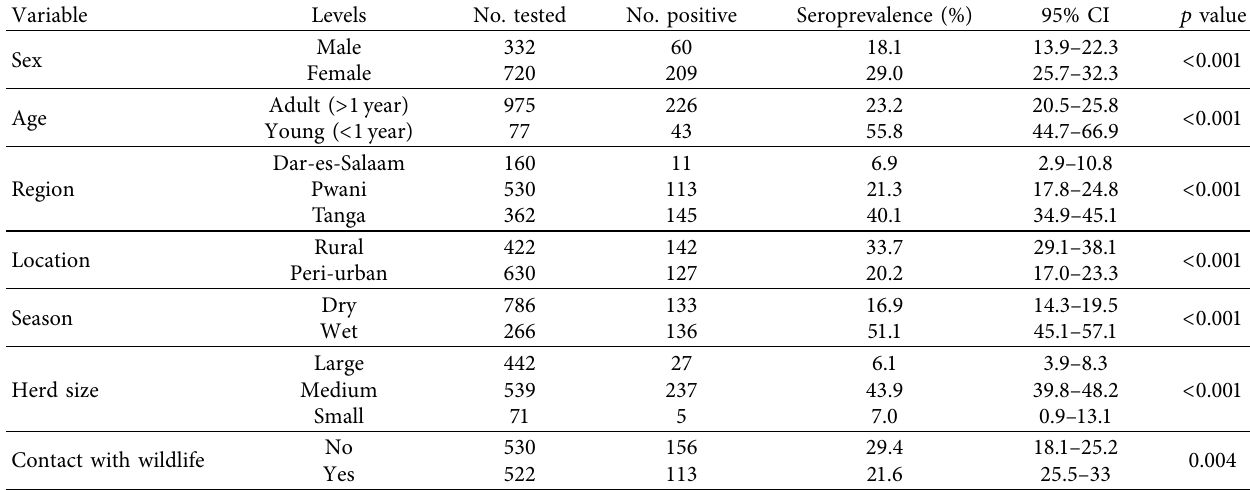
Table 1: Animal-level seroprevalence of brucellosis stratifed by diferent factors, determined from 1,052 serum samples collected from 20 commercial dairy cattle farms in the eastern coast zone of Tanzania.